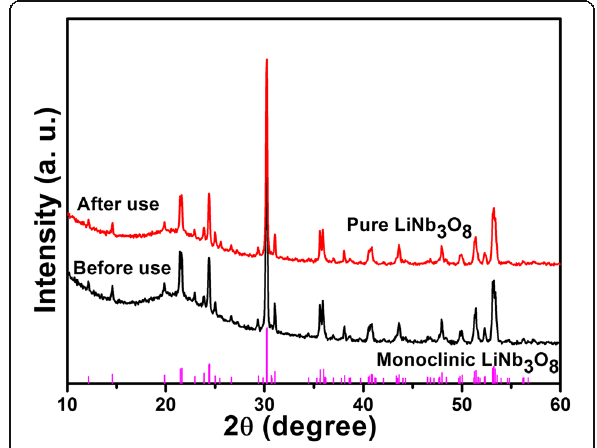
Fig. 9 XRD patterns of LNO800 photocatalysts before and after photo-degradation of MB under UV irradiation